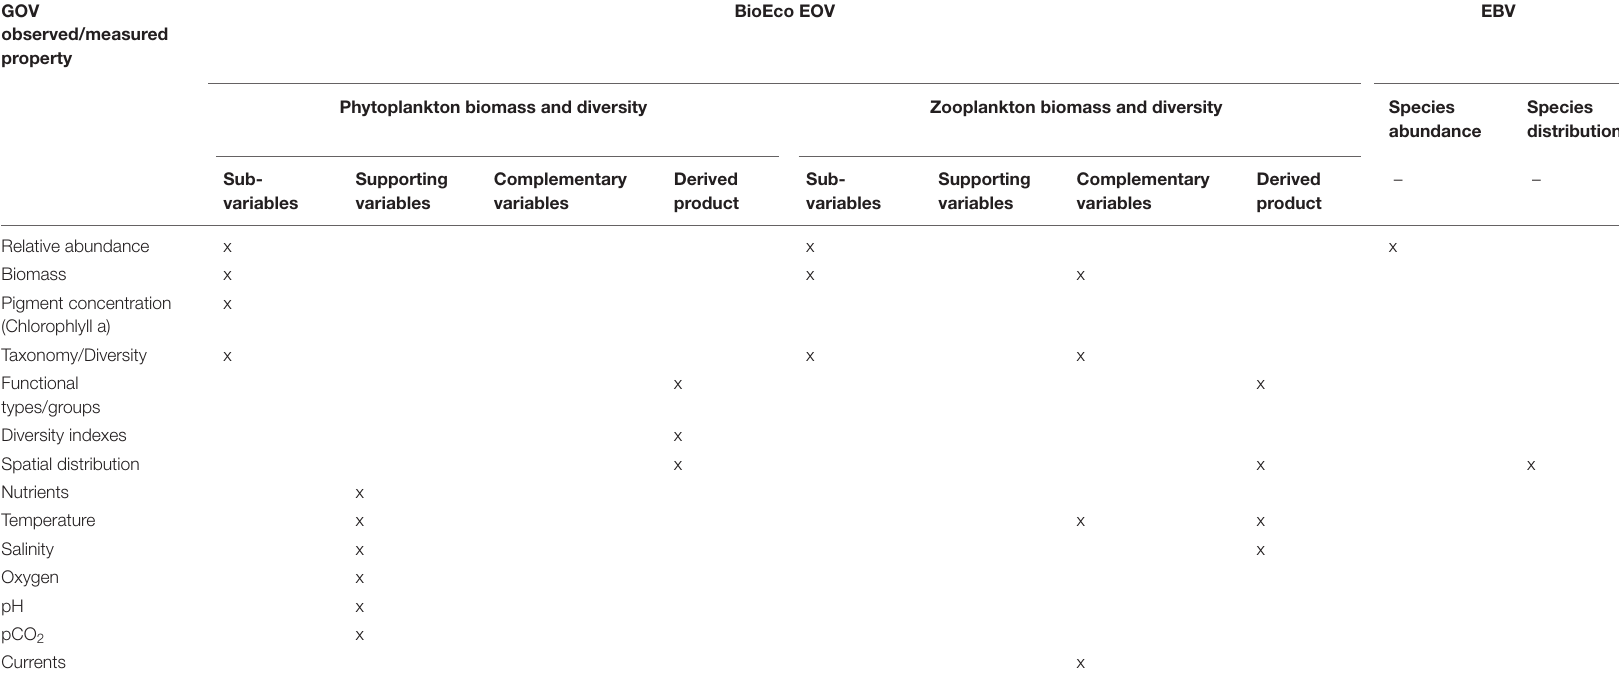
TABLE 3 | Contributions of the GOV to the GOOS and GEO BON frameworks.